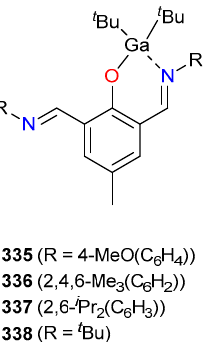
Figure 51. Bis(imino)phenoxide-based Ga complexes [143].